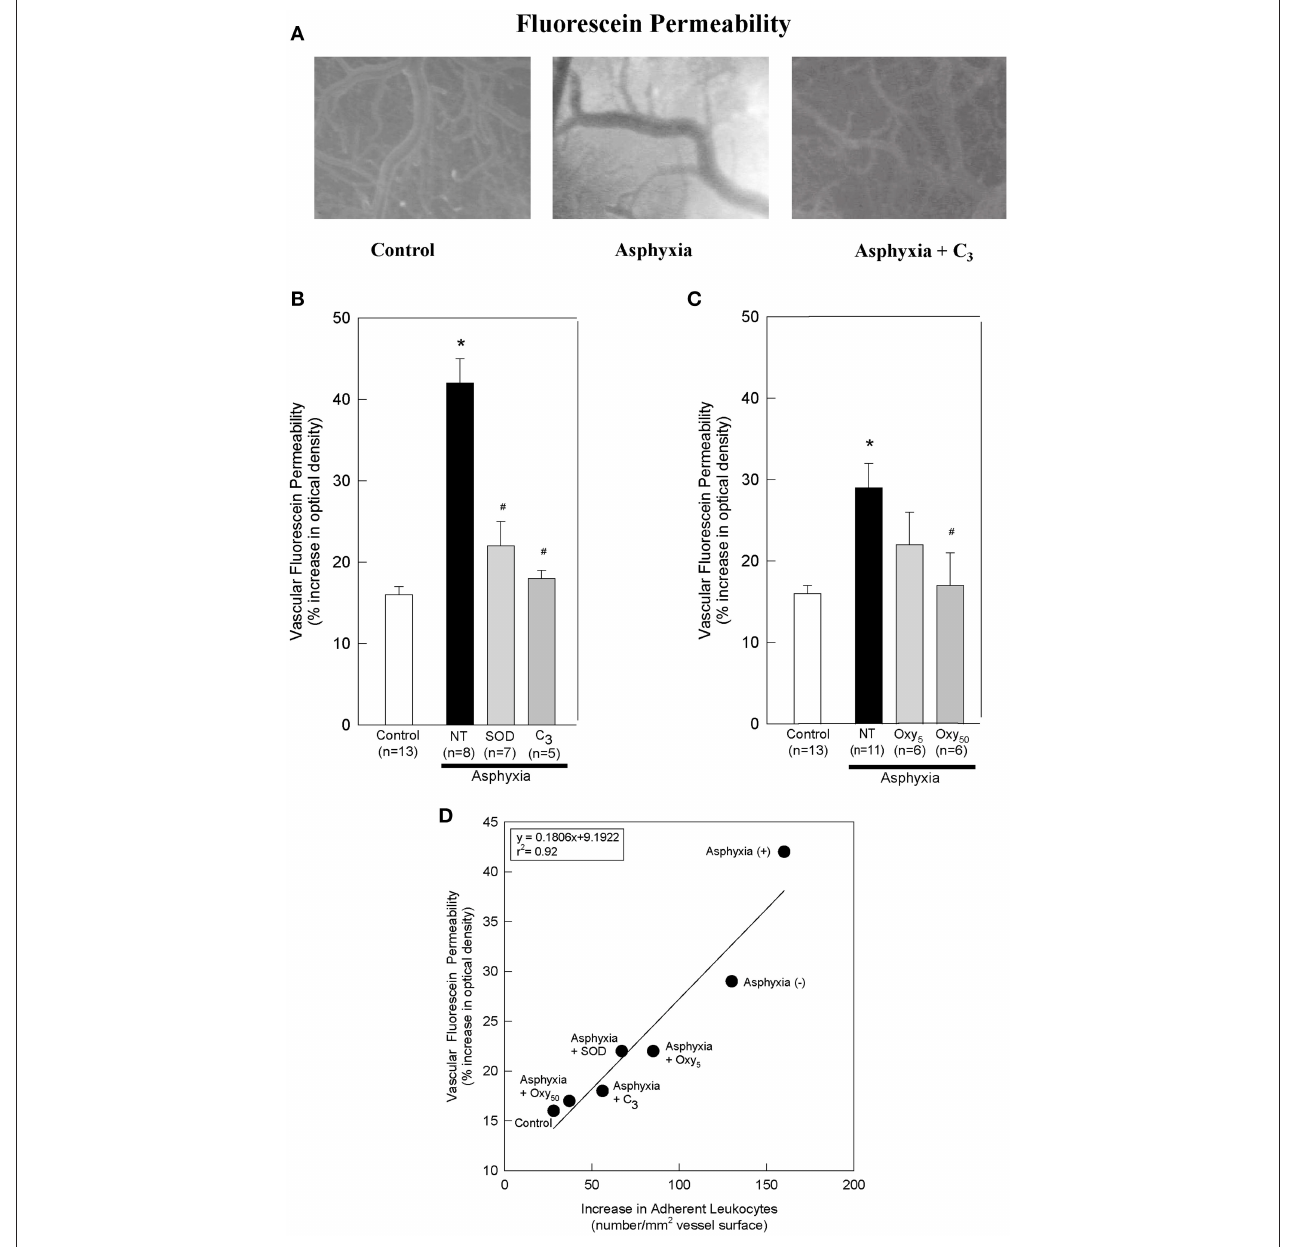
FIGURE 2 | SOD, C 3 , and oxypurinol block the asphyxia-mediated increases in vascular fluorescein permeability, and vascular fluorescein permeability directly correlates with leukocyte adherence. (A) Representative images of sodium fluorescein permeability in control animals, asphyxial animals, and asphyxial animals administered C 3 , at 2h of post-asphyxial reperfusion and 20min after fluorescein administration. Raw images were used for all data analyses, but for publication clarity, images had brightness and contrast enhanced (all images modified equally). (B) Animals induced with asphyxia and concomitant cranial window superfusion with aCSF (NT; n = 8) exhibited a statistically significant increase in vascular fluorescein permeability relative to control animals ( n = 13). Animals continuously administered 1,000 U/ml SOD at a rate of 50 µ l/min by window superfusion ( n = 7) exhibited significantly decreased vascular fluorescein permeability relative to asphyxial animals. Similarly, animals continuously administered 300 µ M C 3 at a rate of 50 µ l/min by window superfusion ( n = 5) exhibited significantly decreased vascular fluorescein permeability relative to asphyxial animals. (C) Animals induced with asphyxia without aCSF superfusion across the cranial window (NT; n = 11) exhibited a statistically significant increase in vascular fluorescein permeability relative to control animals ( n = 13). Animals administered 50 mg/kg oxypurinol ( n = 6) exhibited significantly decreased vascular fluorescein permeability relative to asphyxial animals. Animals administered 5 mg/kg oxypurinol ( n = 6) exhibited no change in vascular fluorescein permeability relative to asphyxial animals. (D) A linear regression was generated by matching leukocyte adherence to the corresponding vascular fluorescein permeability under the different experimental conditions. Values shown (mean ± S.E.M.) represent the percent increase in optical density relative to that measured before fluorescein administration. NT, not treated; ( + ), with aCSF superfusion; (–), without aCSF superfusion. * p < 0.05 vs. control; # p < 0.05 vs. asphyxia.